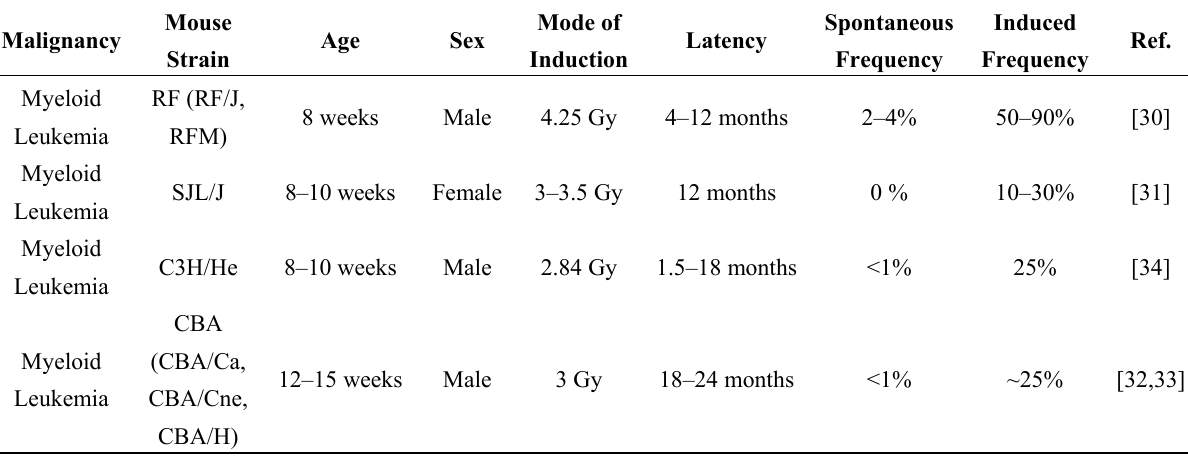
Table 1. Induction of myeloid leukemia in mice with low-LET ionizing